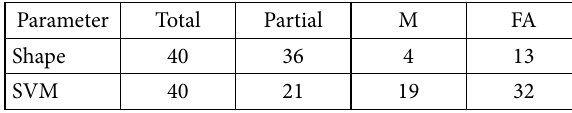
Table 4. Experimental Results – Part